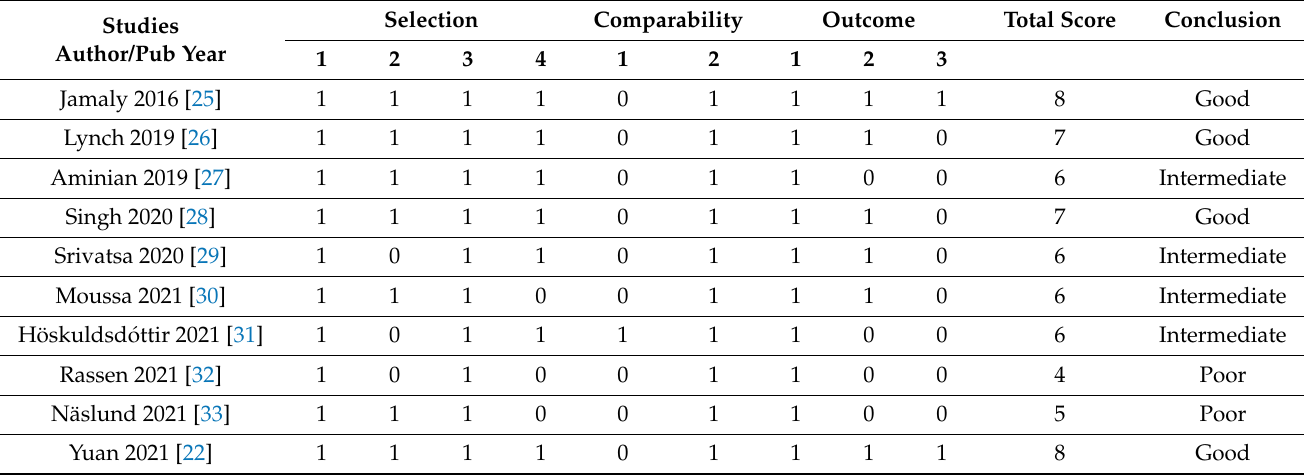
Table 2. Newcastle Ottawa Scale of the studies considered in this meta-analysis [34]. The explication of this scale is reported in the Supplementary